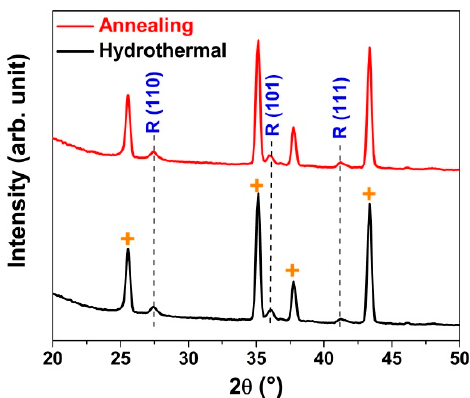
Figure 4. GI-XRD patterns of synthesized nanoporous TiO 2 film and after annealing, red and black spectra are almost overlapping.